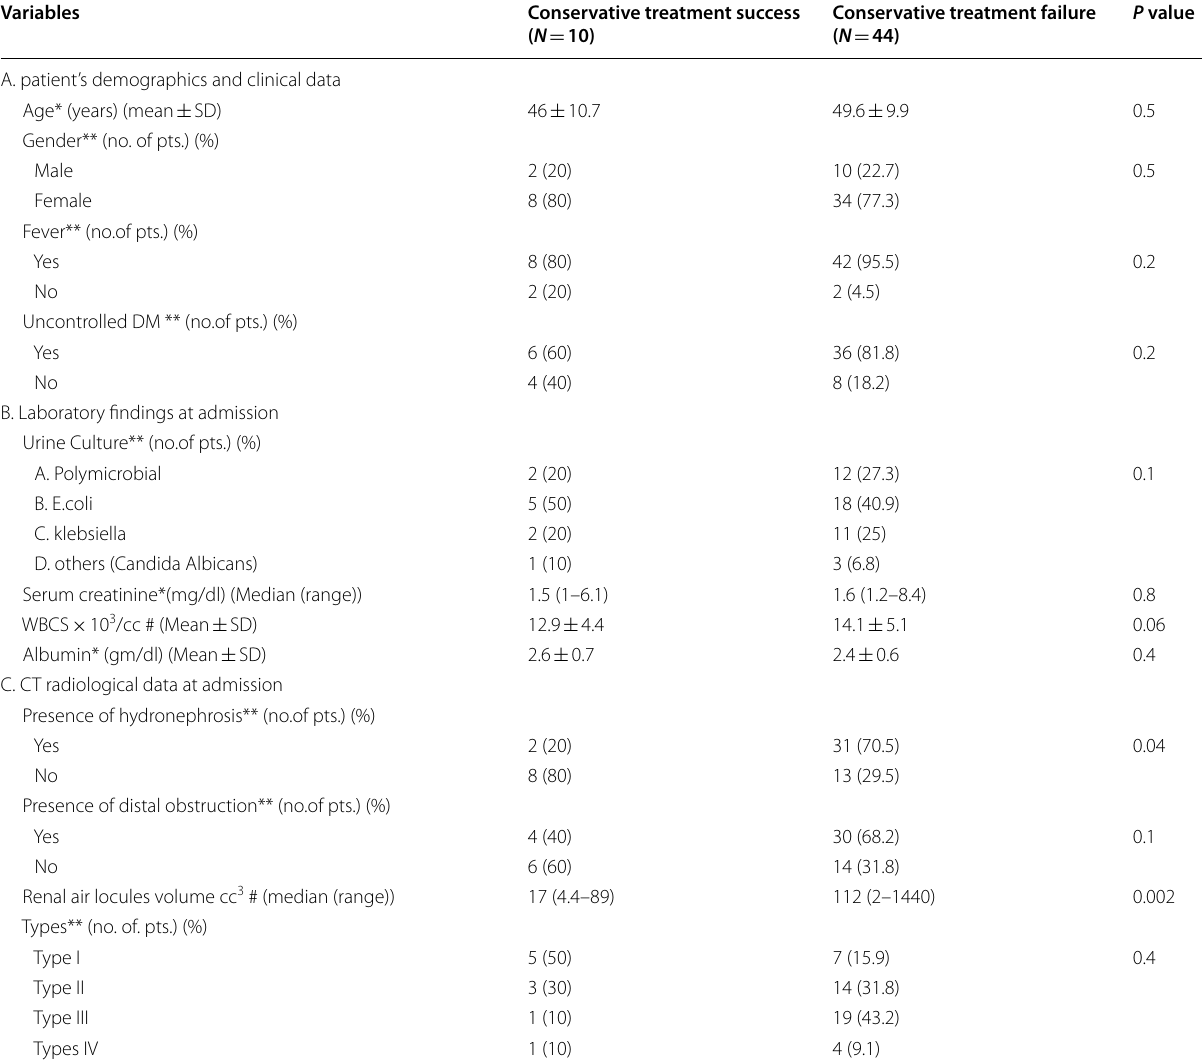
*Independent sampled t test, **Chi-square test and # Mann–Whitney test and No. of. pts.